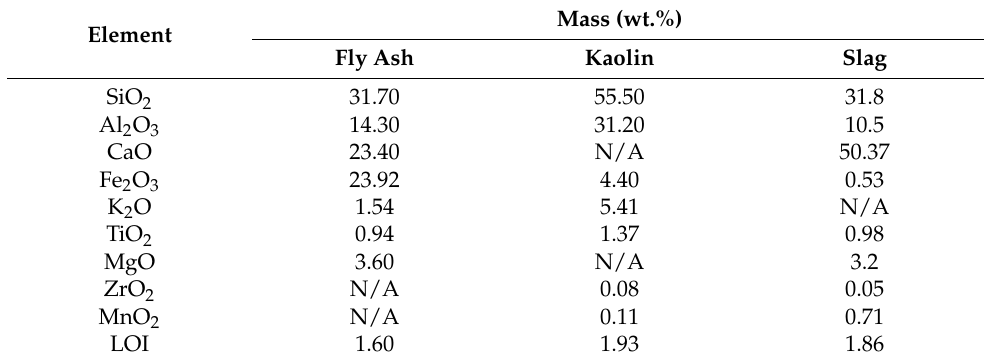
Table 1. Chemical composition of kaolin, slag, and fly ash obtained by X-ray fluorescence.